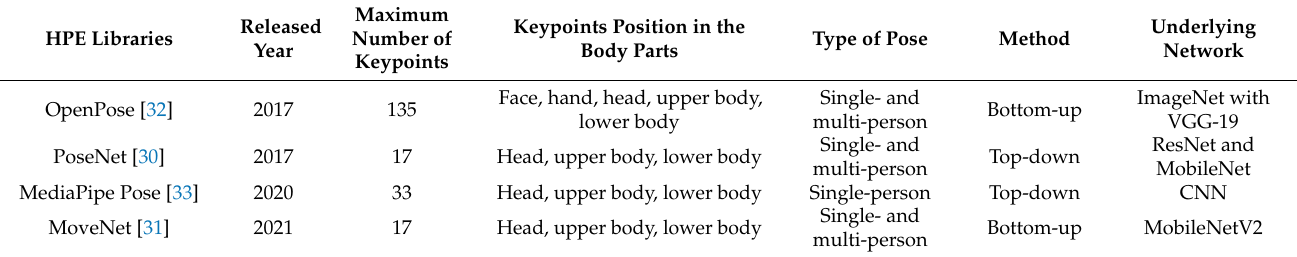
Table 2. Specifications of each HPE